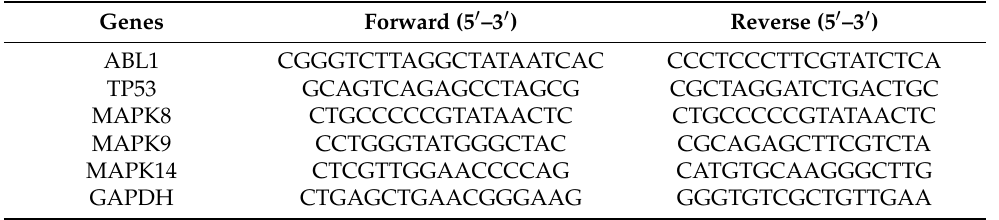
Table 1. Primer sequences used for quantitative RT-PCR analysis.